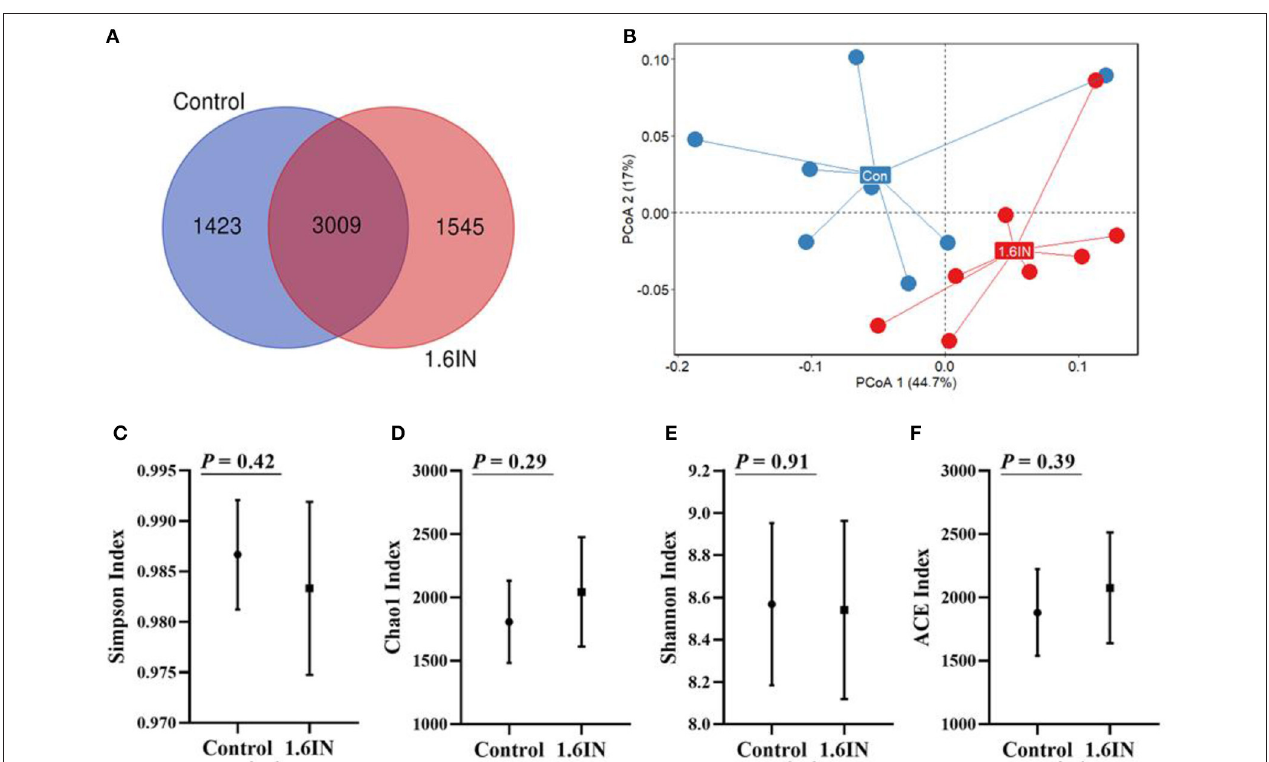
FIGURE 6 | (A) Venn diagram exhibits the shared and unique operational taxonomic units (OTUs) between two groups and (B) principal component analysis (PCoA) based on genus level, each point represented one sample, blue points from the control group and red points from the 1.6IN group. (C) Simpson index; (D) Chao1 index; (E) Shannon; (F) ACE index. Significance was analyzed by an unpaired t